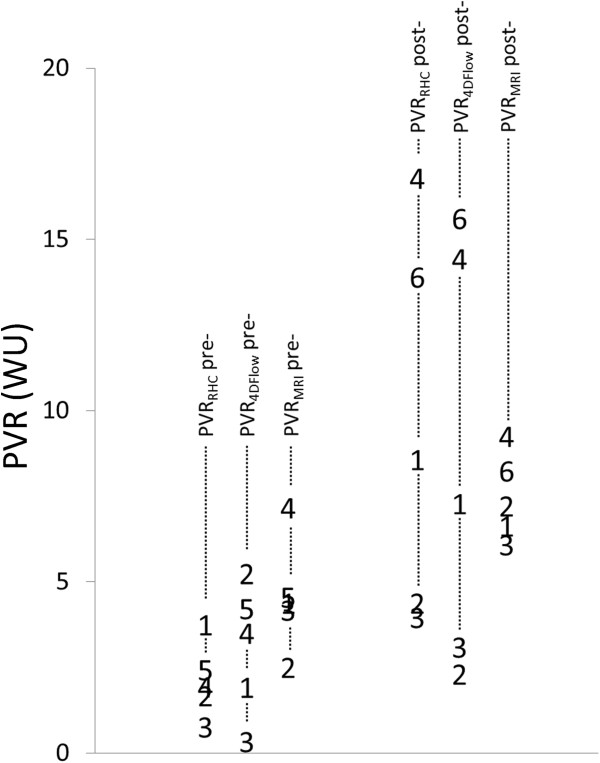
Scatter-plot of PVRRHC, PVR4Dflow and PVRMRI pre- and post-embolization. PVRRHC and PVRMRI increased post-embolization in all cases. In one case, PVR4Dflow was lower post-embolization than pre-embolization, presumably due to lack of an increase in tricuspid regurgitation (TR) jet velocity or incorrect selection of the peak TR velocity.